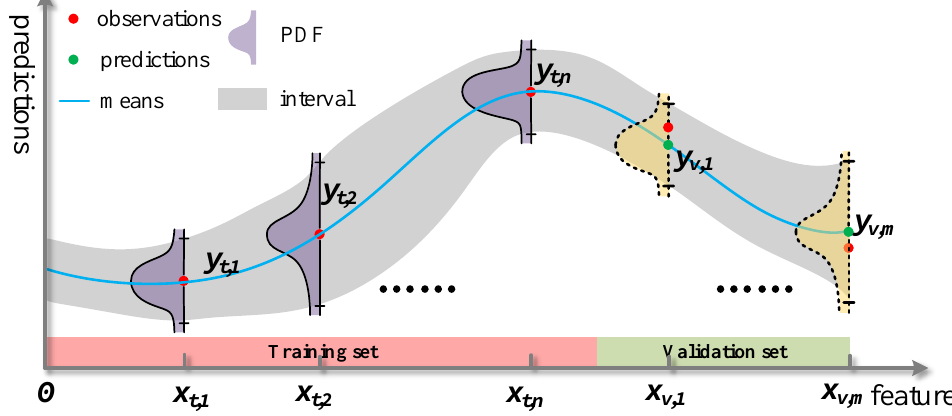
Figure 2. Schematic diagram of decision tree growth strategy.